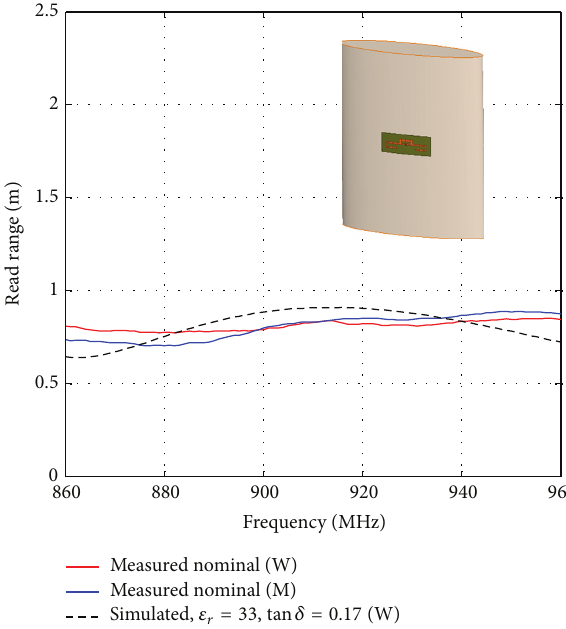
Figure 12: Measured and simulated reference tag on human chest and human chest model,